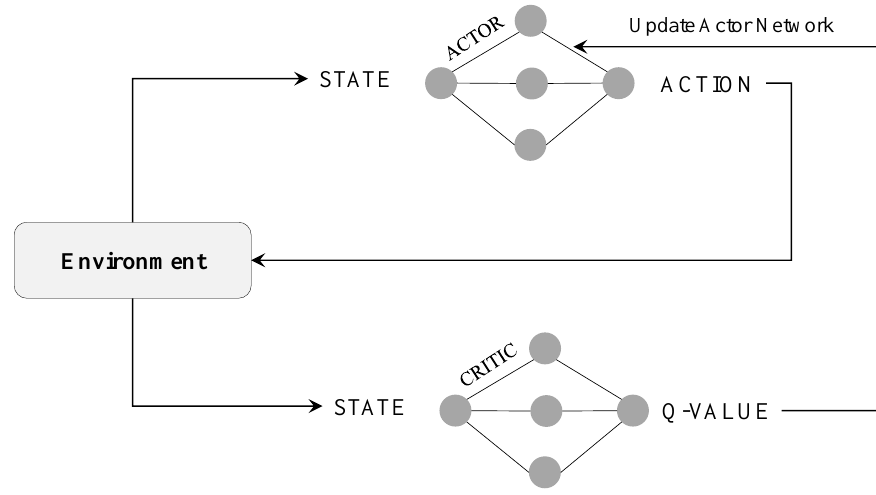
Figure 5. The loop of the Actor–Critic